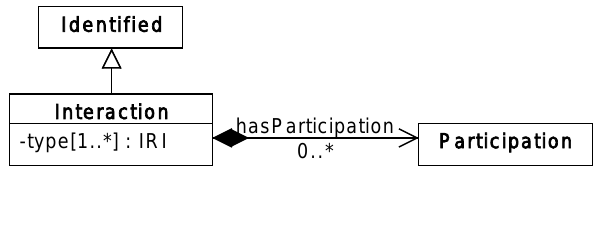
Figure 12: Diagram of the Interaction class and its associated